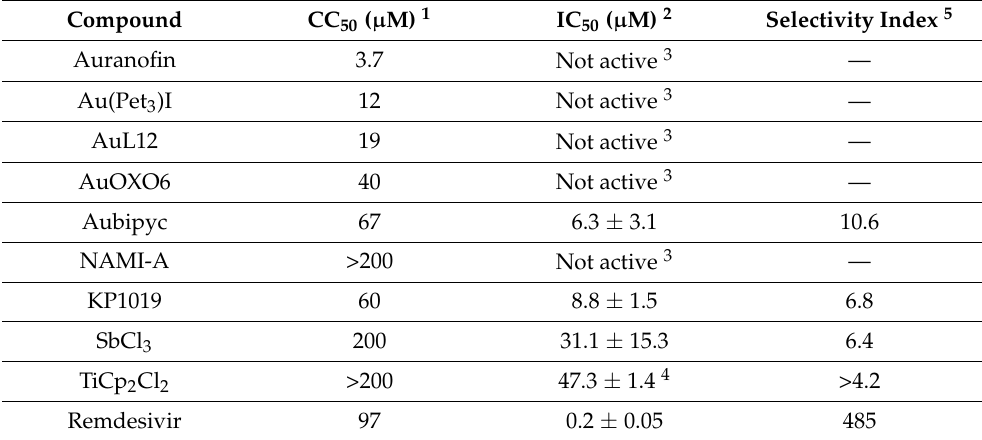
Table 1. Cytotoxicity and antiviral activity of metallic compounds. All compounds were tested by the direct yield reduction assay (DYRA) protocols. The compounds not active in DYRA were subsequently screened using the secondary yield reduction assay (SYRA) to evaluate possible activity in the late phases of viral replication not detectable with DYRA. Compound CC 50 ( µ M) 1 IC 50 ( µ M) 2 Selectivity Index 5 Auranofin